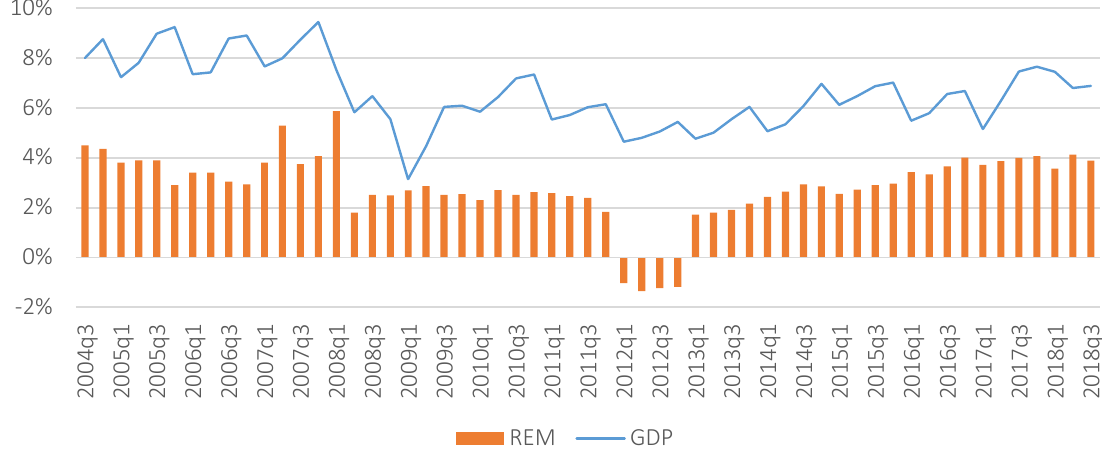
Figure 4. Real estate market (REM) and economic growth (GDP)